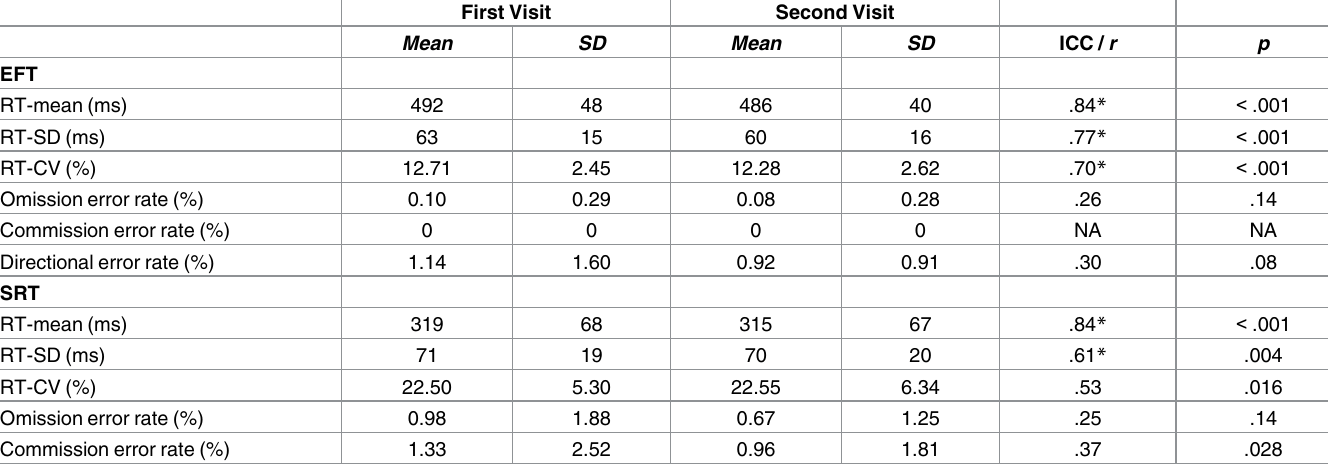
Table 2. Test-retestreliability of conventional measurements of the Eriksen flanker task (EFT) and simple reaction task (SRT). Intra-class correla- tion (ICC) coefficientswere calculatedfor RT-mean, RT-SD, and RT-CV values. Spearmancorrelationcoefficients ( r ) were calculatedfor error rates. First Visit Second Visit